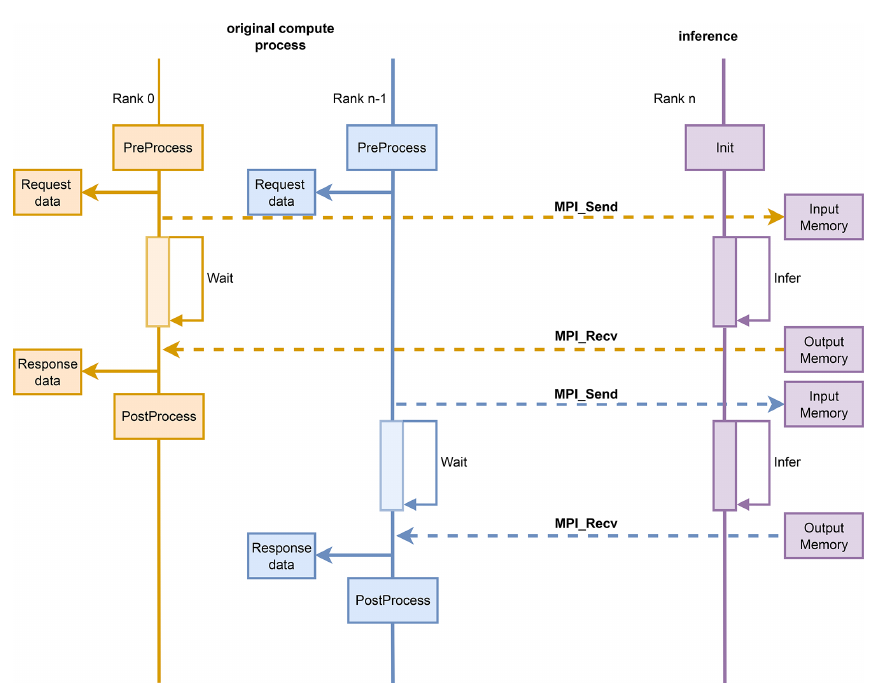
Figure 4. Synchronous sequence implementation between WRF and ML-based parameterization.